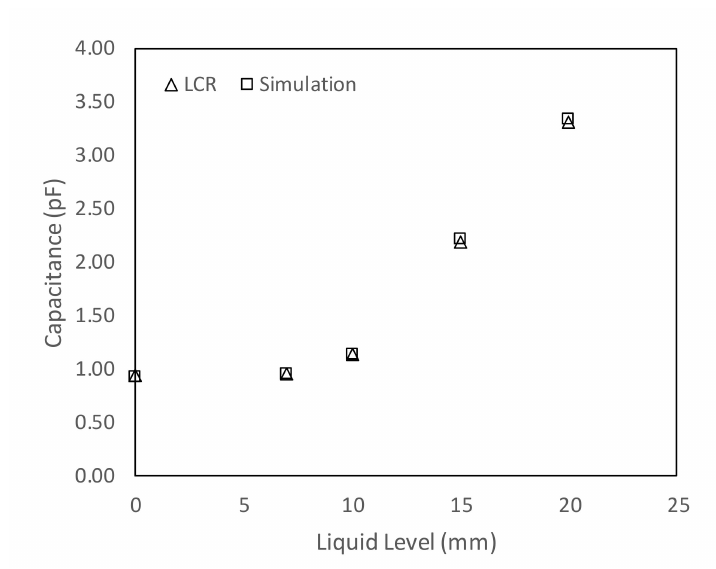
Figure 6. Numerical simulation of the capacitance values vs. LCR capacitance